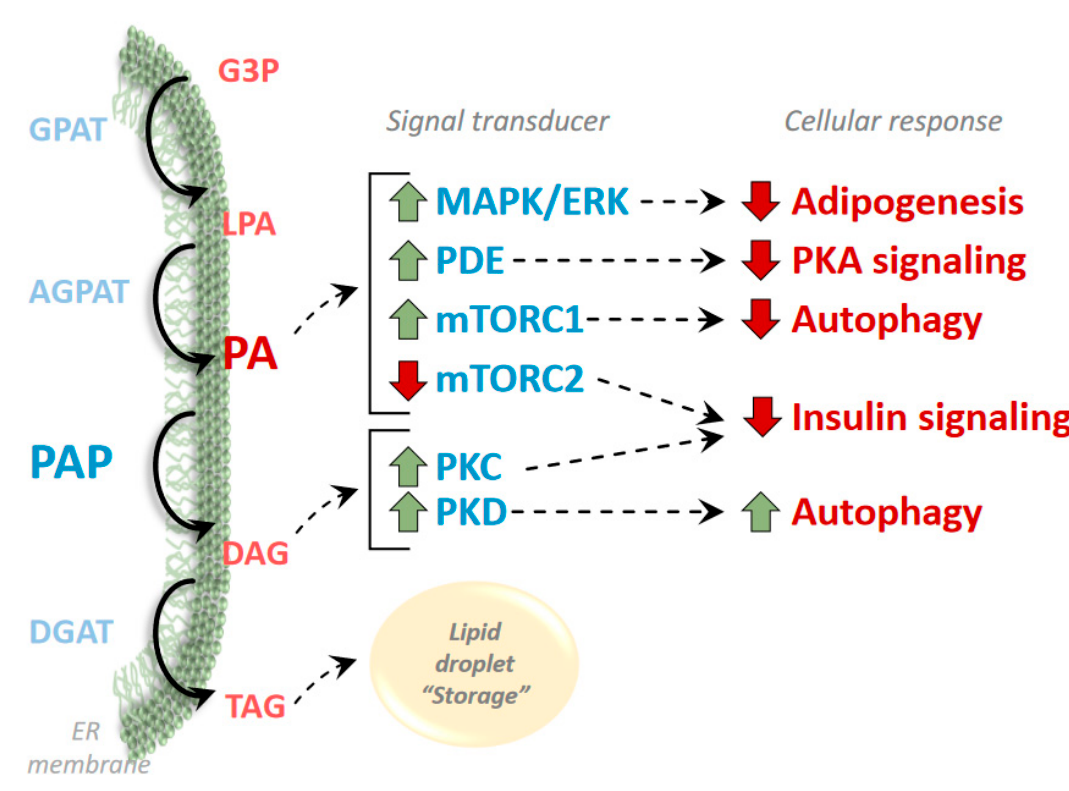
Figure 3. PAP derived phosphatidic acid activates several signaling cascades. Phosphatidic acid (PA) and diacylglycerol (DAG) synthesized from PAP activity effects several signaling modules involved in metabolism, autophagy, and differentiation. Enzyme abbreviations not listed in Figure 1 in blue : Mitogen Activated Protein Kinase (MAPK), Extracellular Regulated Kinase (ERK), phosphodiesterase (PDE), mechanistic Target of Rapamycin Complex 1 & 2 (mTORC1, mTORC2), Protein Kinase C (PKC), Protein Kinase D (PKD).